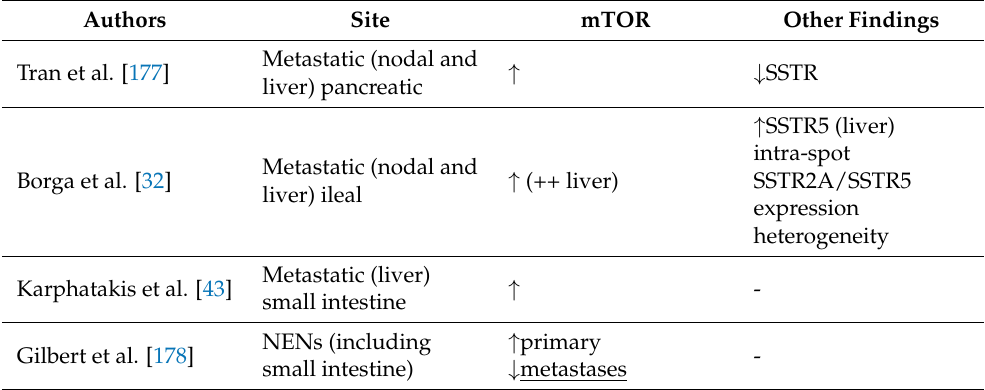
Table 2. mTOR pathway alterations in gastroenteropancreatic neuroendocrine neoplasms (GEP-